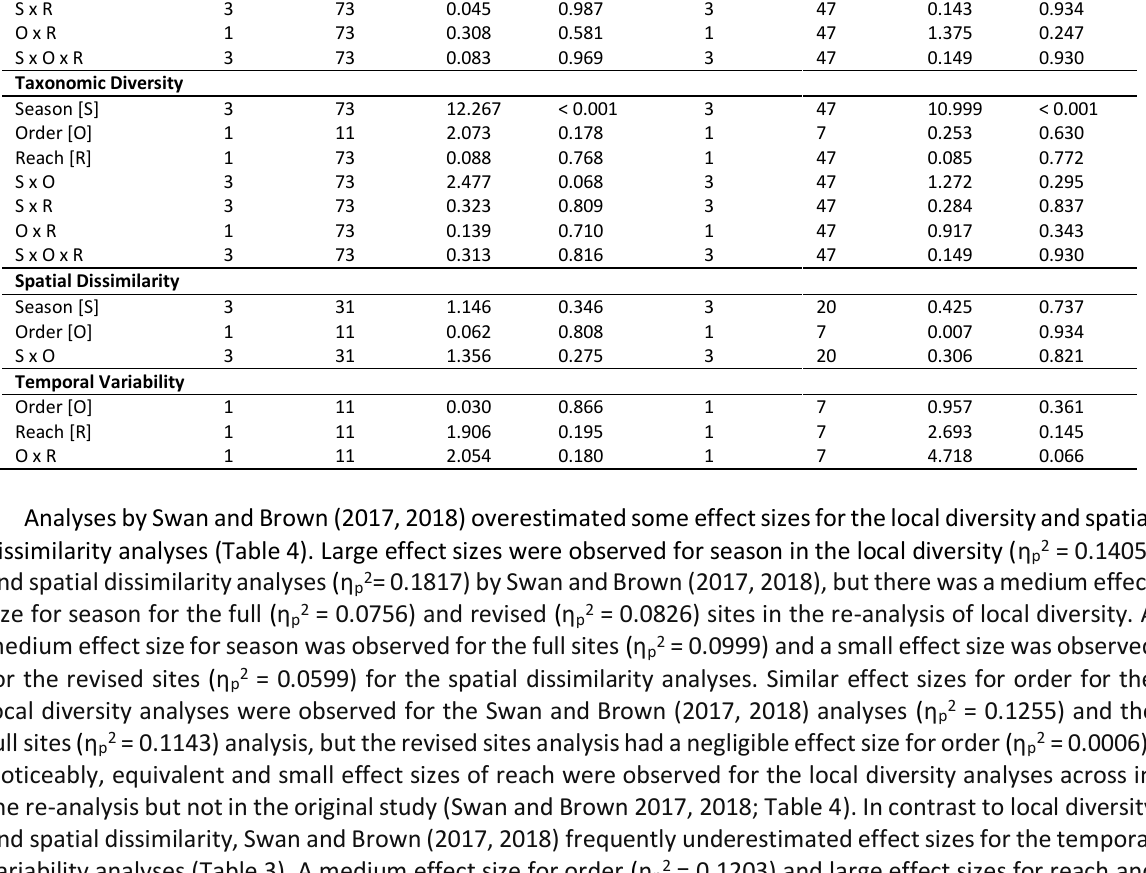
local diversity analyses were observed for the Swan and Brown (2017, 2018) analyses ( η p2 = 0.1255) and the full sites ( η p2 = 0.1143) analysis, but the revised sites analysis had a negligible effect size for order ( η p2 = 0.0006). Noticeably, equivalent and small effect sizes of reach were observed for the local diversity analyses across in the re-analysis but not in the original study (Swan and Brown 2017, 2018; Table 4). In contrast to local diversity and spatial dissimilarity, Swan and Brown (2017, 2018) frequently underestimated effect sizes for the temporal variability analyses (Table 3). A medium effect size for order ( η p 2 = 0.1203) and large effect sizes for reach and the order-by-reach interaction were observed in the revised sites analysis (reach η p 2 = 0.2779, order-by-reach η p 2 = 0.4026), with the largest effect size from all analyses and community diversity metrics derived from